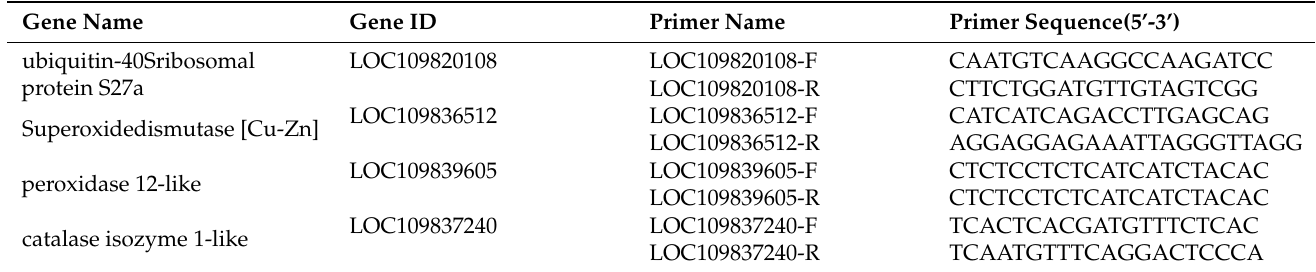
Table 1. The following primers were used in this experiment.